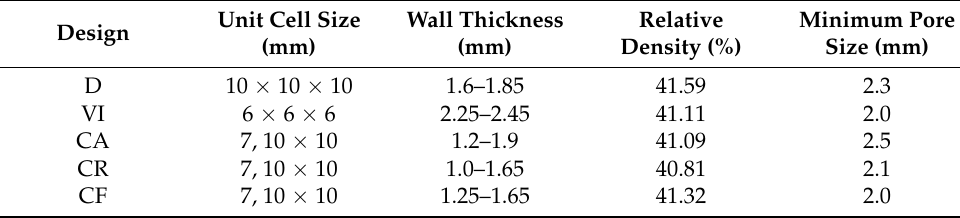
Figure 5. Longitudinal and radial density gradient in five functional gradient designs. Table 1. Summary of dimensions for the five functionally gradient